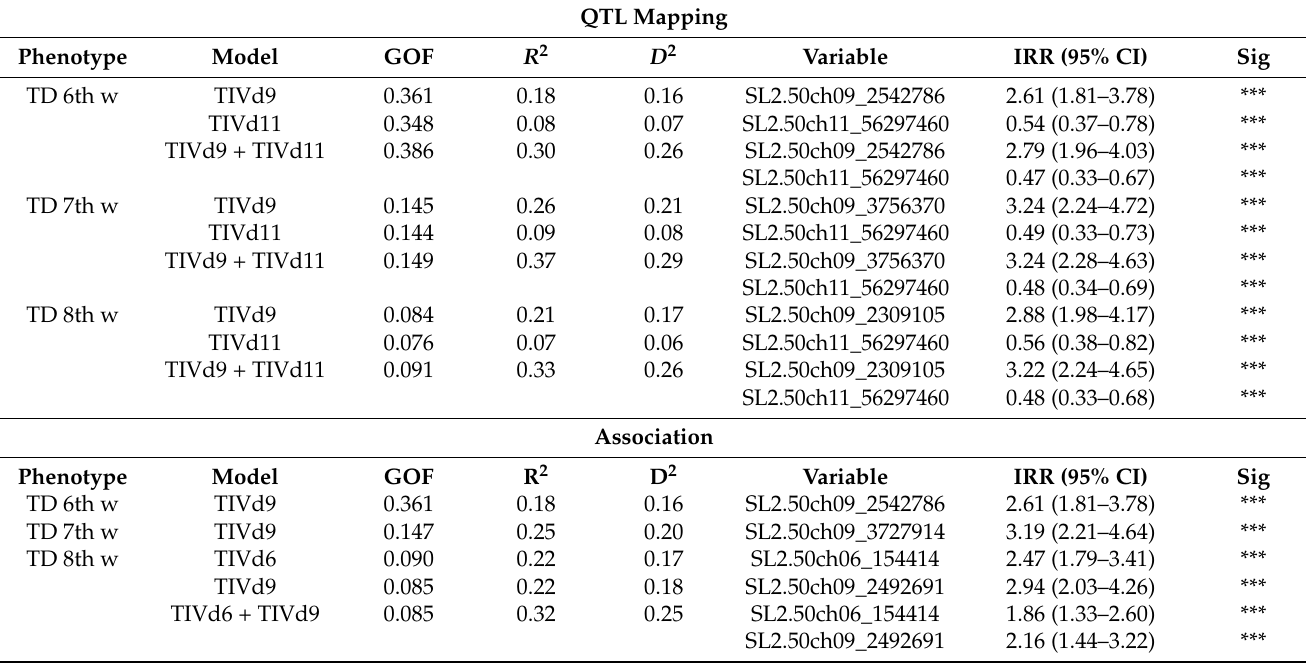
Table 3. Results of the negative binomial logistic regression for the QTLs found by QTL mapping and association analysis. Different statistical models using trichome density (TD) after 6,7 or 8 weeks after transplanting and either a single predictor or an additive model are shown. Independent variables used correspond to the number of alleles of the high density parental at the marker with the highest statistical support. For each model, χ 2 goodness of fit p -value of the model (GOF), Nagelkerke R 2 , explained deviance ( D 2 ) and point estimated of incidence rate ratio (IRR) and 95% confidence interval are reported. *** p -value <